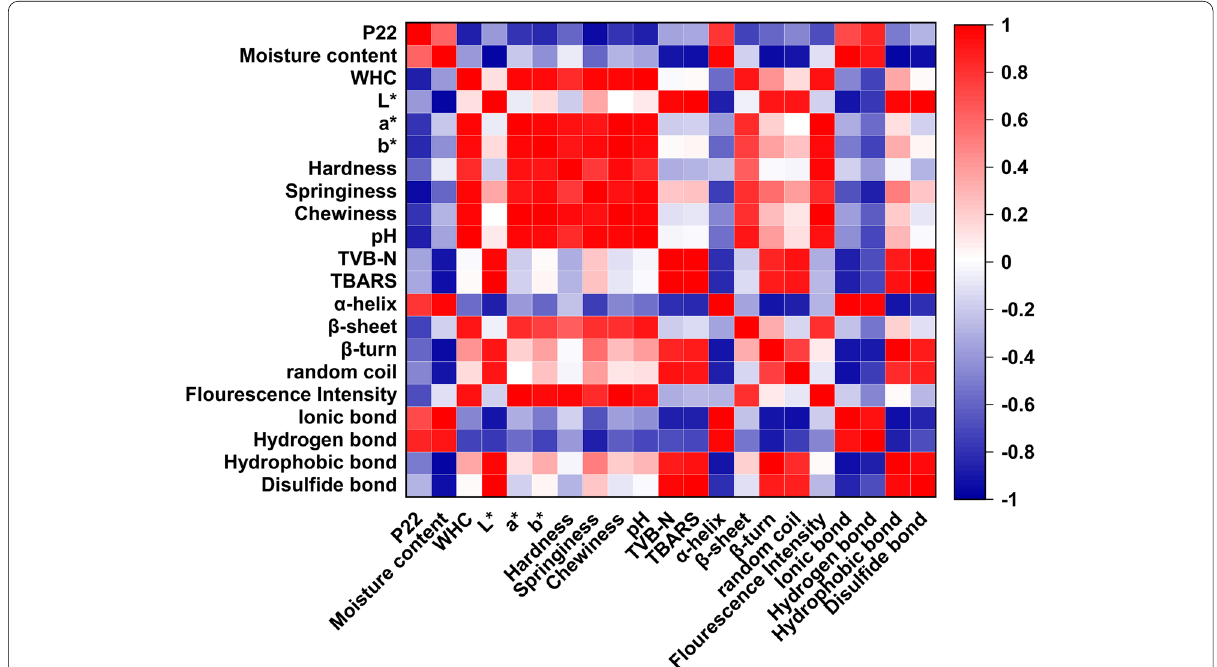
Fig. 5 Pearson correlations of physicochemical properties and structure on cooked crayfish (P 22 : percentage of T 22